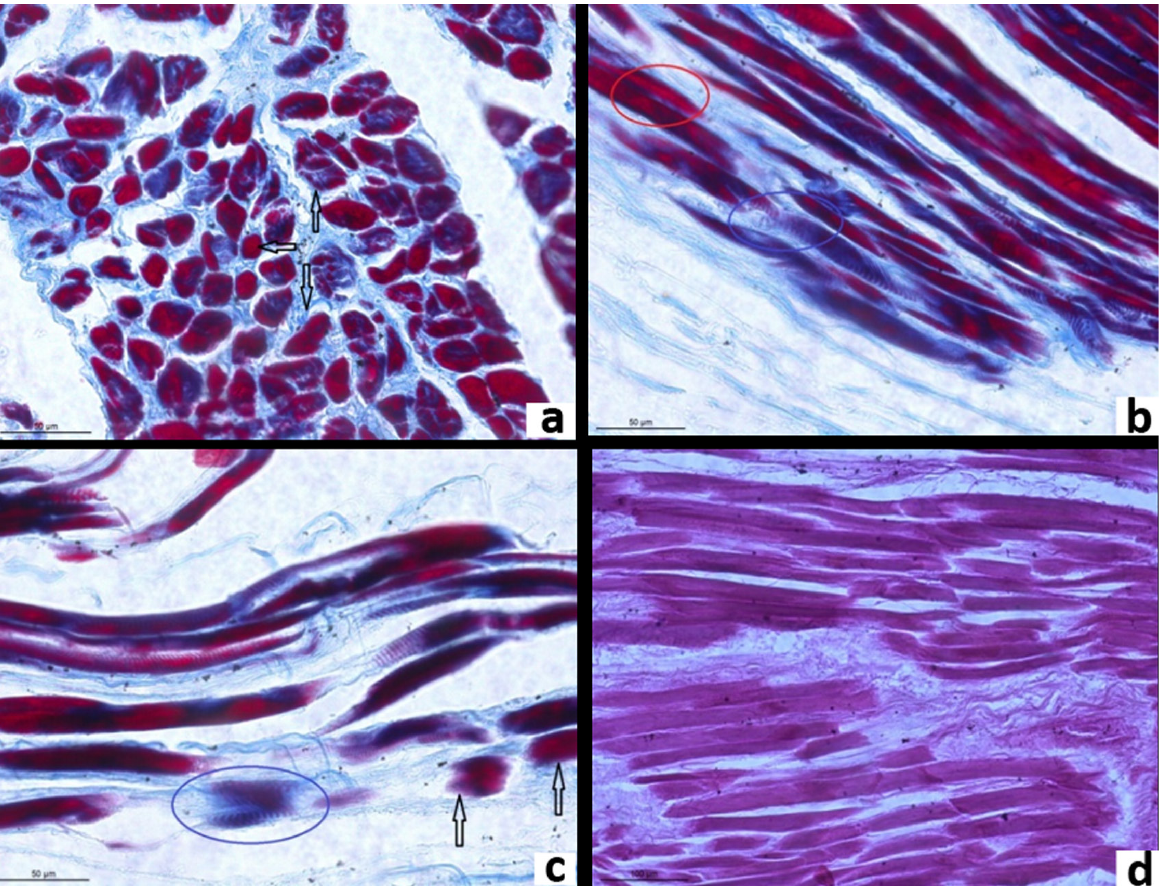
Figure 2 - Photomicrographs of sectional portion of diaphragmatic muscle. a - show the diameter of the muscle fibers staple in varying sizes (arrows). Stained: Masson trichrome. Scale Bar: 50 µm. b - oblique cut the muscle portion with subsequent staining using Gomori trichrome revealed the diaphragmatic muscles (red circle) and the collagen fibers (blue circle). It was observed that the variety in the diameter of muscle fibers and staple their striae. Scale Bar: 50 µm. c - provision of muscle fibers (arrows) and mainly of striae. Stained: Masson trichrome. Scale Bar: 50 µm. d - muscle fibers and striae. Stained: Hematoxylin-eosin. Scale Bar: 100